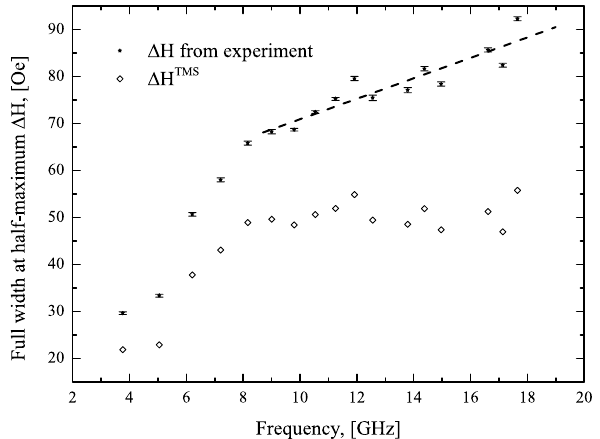
Figure 6. Resonance line full width at half maximum for the 30 nm CFMS sample without additional silver buffer layer as a function of frequency at room temperature. Solid line presents a linear fit for the frequencies above 8 GHz, which slope is proportional to α eff . Empty symbols present the extracted as described above, two magnon scattering contribution (TMS).